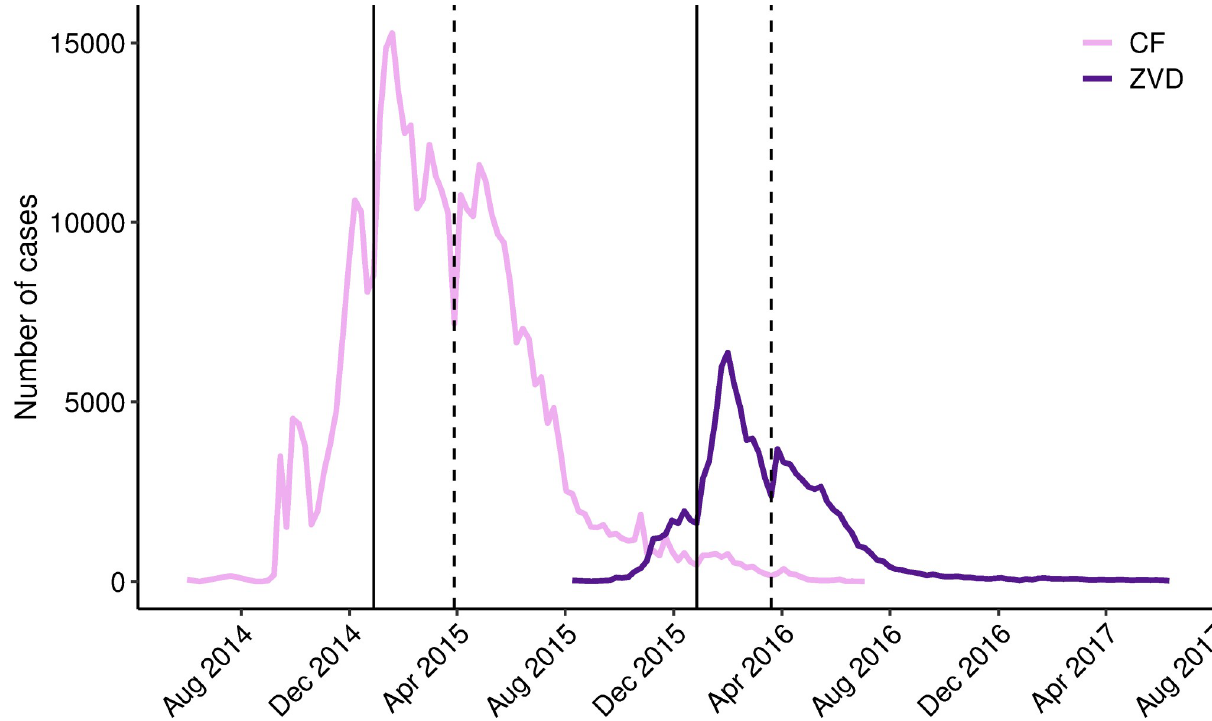
Fig 3. Number of chikungunya fever (CF) and Zika virus disease (ZVD) cases reported each week during the 2014–2017 epidemic in Colombia. Dotted lines mark the weeks preceding Easter in 2015 (epidemiological week 13) and 2016 (epidemiological week 12). Solid lines mark the weeks preceding New Year’s Day in 2015 (epidemiological week 53 of 2014) and 2016 (epidemiological week 52 of 2015).